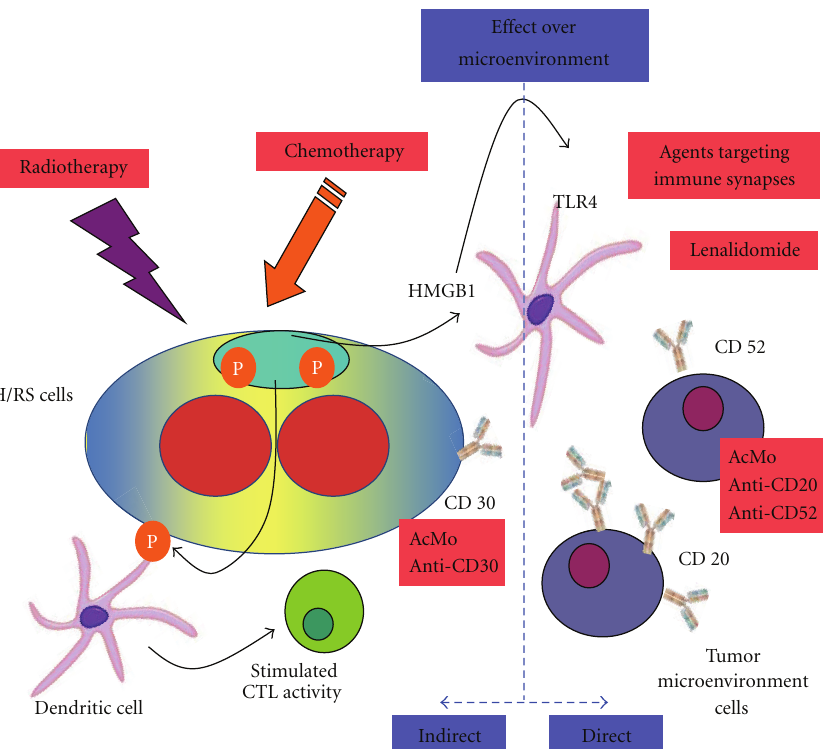
Figure 5: Therapeutic strategies to overcome immune escape in HL. AcMo: monoclonal antibodies. H/RS cells: Hodgkin’s/Reed-Sternberg cells. CTL: cytotoxic T lymphocytes. HMGB1: high-mobility group protein B1. TLR4: Toll-like receptor